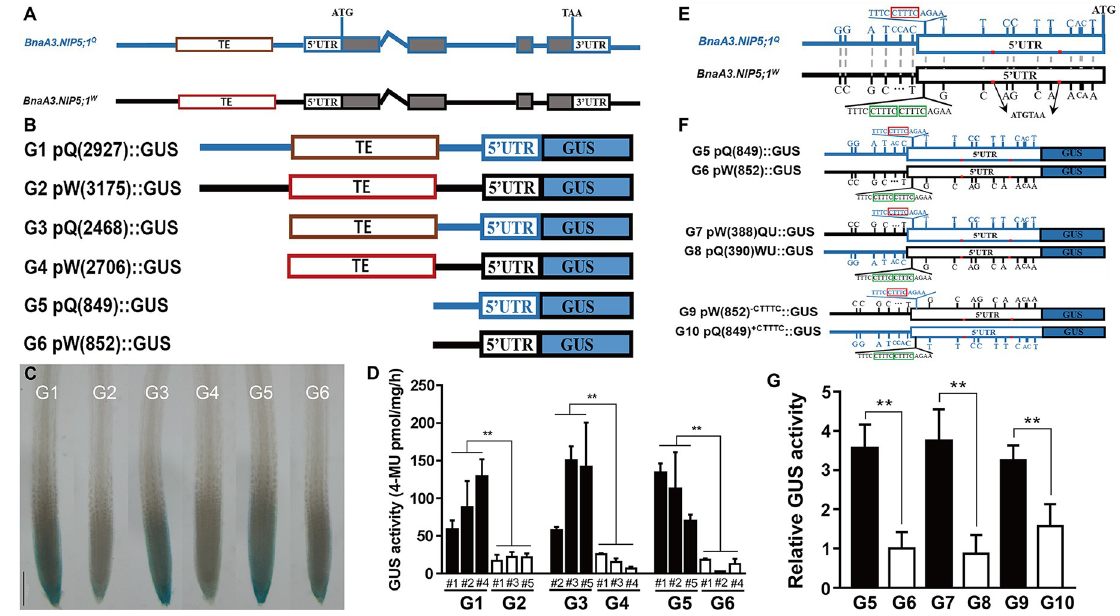
Fig 5. A CTTTC tandem repeat in the 5’UTR confers the different expression of BnaA3 . NIP5;1 . ( A ) Schematic diagram of BnaA3 . NIP5;1 in QY10 and W10. The white boxes represent 5’UTRs and 3’UTRs, grey boxes represent exons, the lines between grey boxes represents introns, and the brown and red boxes represent different TEs from QY10 and W10, respectively. ( B ) Constructs used for Arabidopsis transformation. G1 pQ(2927)::GUS contains the 2927 bp promoter of QY10. G2 pW(3175)::GUS contains the 3175 bp promoter of W10, and G3-G6 have a 5’ series deletion as indicated. ( C and D ) GUS staining and activity of transgenic plants harbouring G1-G6 constructs. Seedlings of the G1-G6 transgenic plants were grown on solid media consisting of 0.3 μ M B for 10 d. Scale bar, 100 μ m. ( E ) Variations in the 849 bp fragment in the promoters of QY10 and W10. CTTTC tandem repeats are indicated by the red box in the BnaA3 . NIP5;1 Q promoter and the green box in the BnaA3 . NIP5;1 W promoter, respectively. The red bars indicate uORFs, and minus signs indicate nucleotide deletions and polymorphisms. ( F ) Constructs used for tobacco transformation. The 5’UTR and CTTTC repeat in G5/ G6 were exchanged to generate G7/G8 and mutated to generate G10/G9 constructs. ( G ) Relative GUS activity of different constructs (G5-G10), (CaMV) 35S-luciferase was co-transfected and used as an internal control. The data presented are mean values with s.d. Three replicates were used in ( D ), and six replicates were used in ( G ). �� P < 0.01 (Student’s t